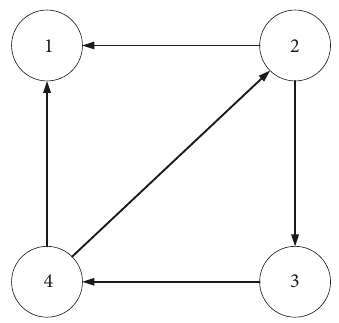
Figure 8: The directed network topology.